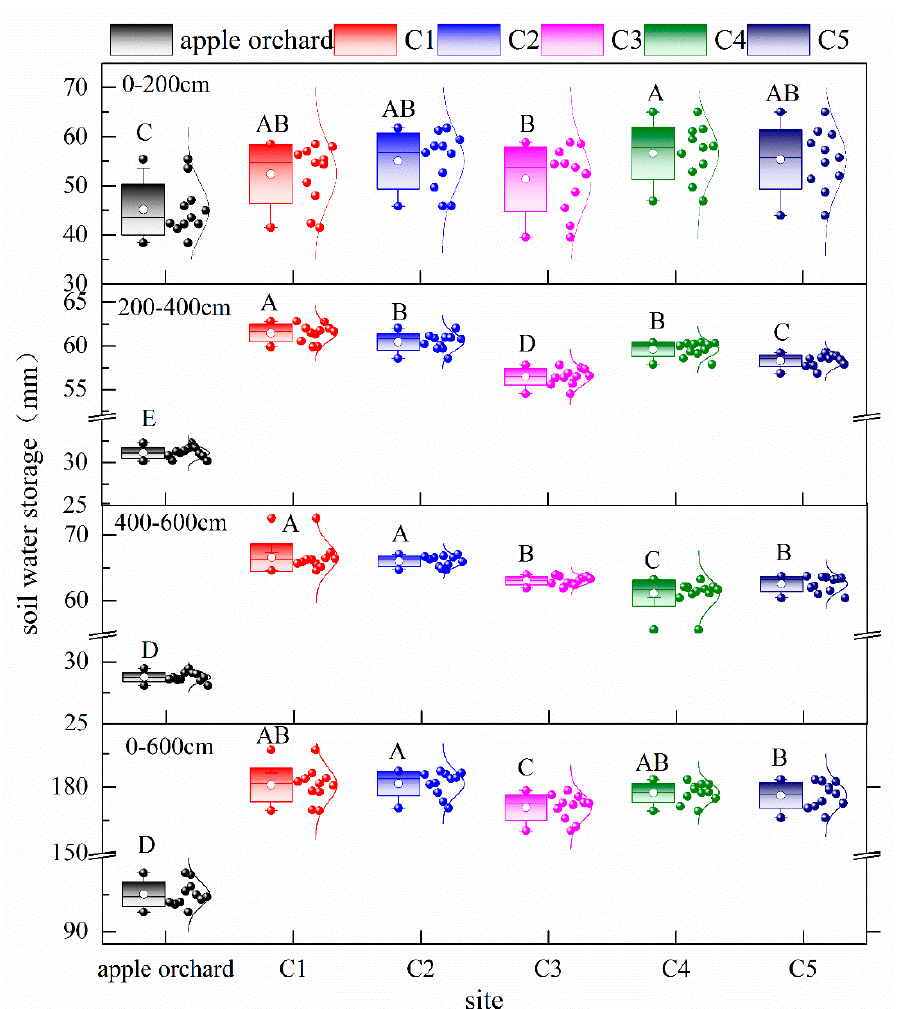
Figure 8. Variations in soil water storage during the growing season in 2014 of each site. A distribution curve is on the right side of each box plot and data points are represented by spheres. Different letters indicate significant differences ( p <0.05).